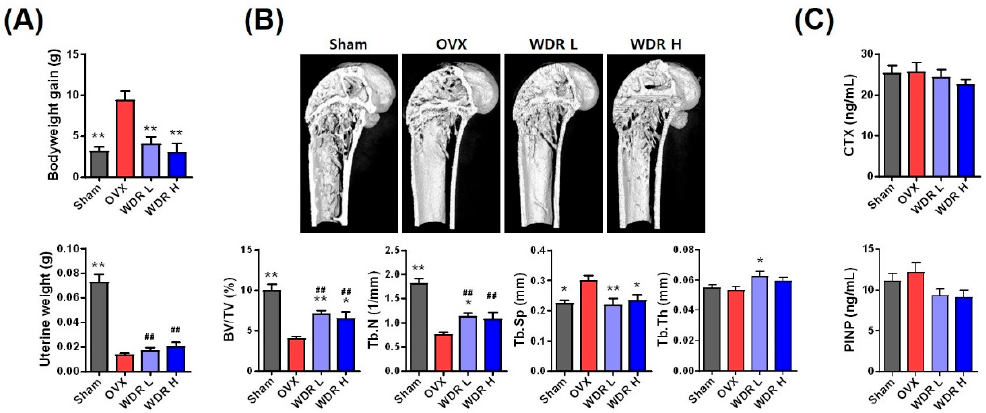
Figure 1. Effects of water extract of D. roosii (WDR) on bone loss in high fat diet (HFD)-fed ovariectomized (OVX) mice. ( A ) Changes in body and uterine weight. ( B ) µ-CT images and morphometric parameters in the distal femur. ( C ) Serum levels of CTX-1 and PINP. Sham, sham mice fed HFD OVX, OVX mice fed HFD; WDR L, OVX mice fed HFD and WDR 200 mg/kg/day; WDR H, OVX mice fed HFD and WDR 500 mg/kg/day. Results are presented as mean ± SEM and analyzed using a one-way analysis of variance and Dunnett's post hoc test. * p < 0.05, ** p < 0.01 versus the OVX group, ## p < 0.01 versus the Sham group.